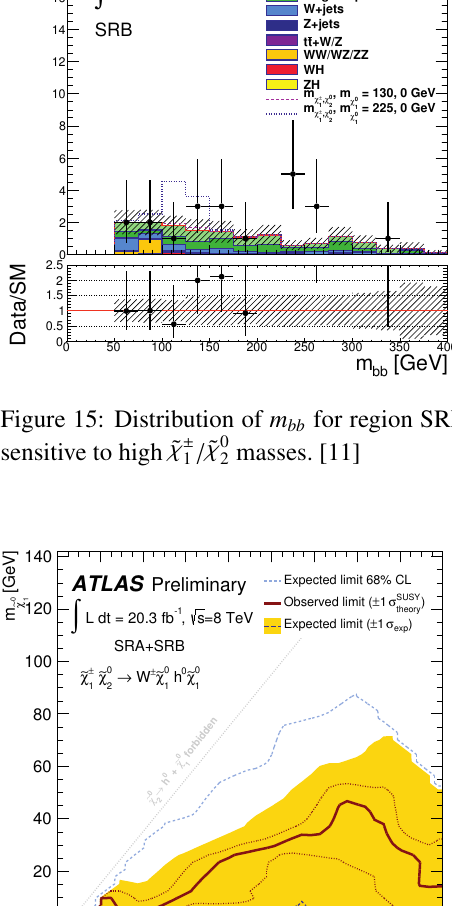
Figure 16: Exclusion limits in the m plane. The 68% CL expected exclusion